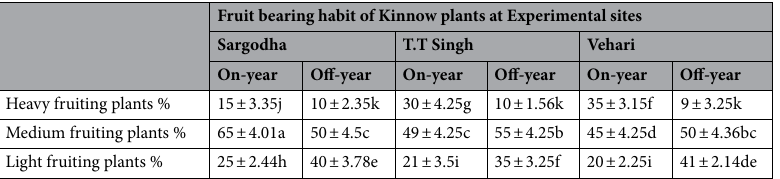
Fruit bearing habit of Kinnow plants at Experimental sites